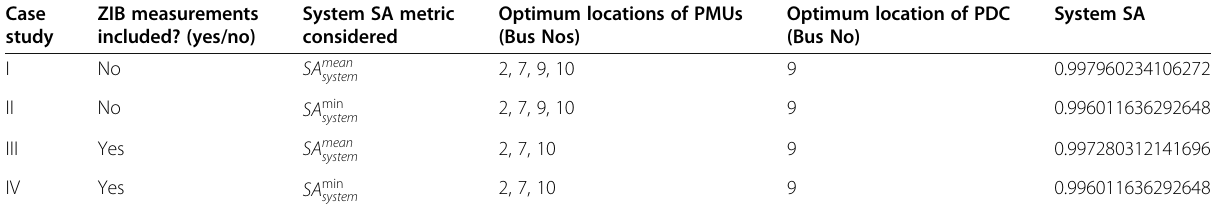
Table 6 A summary of the case studies Case study